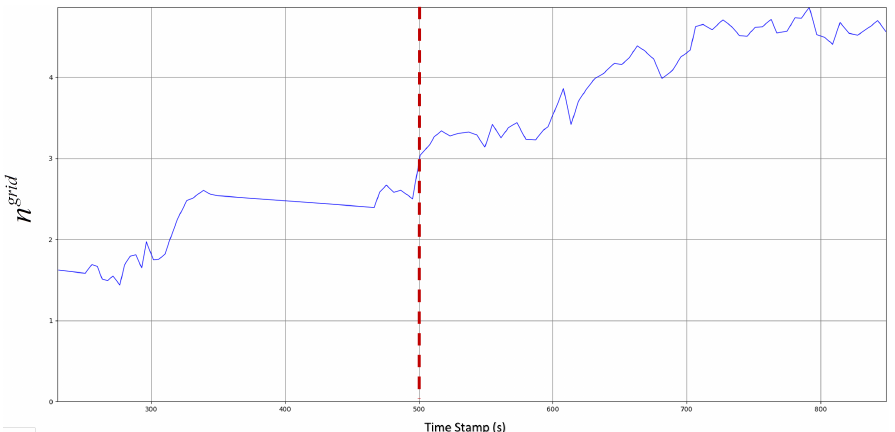
Figure 17. Completeness evaluation in distribution-based